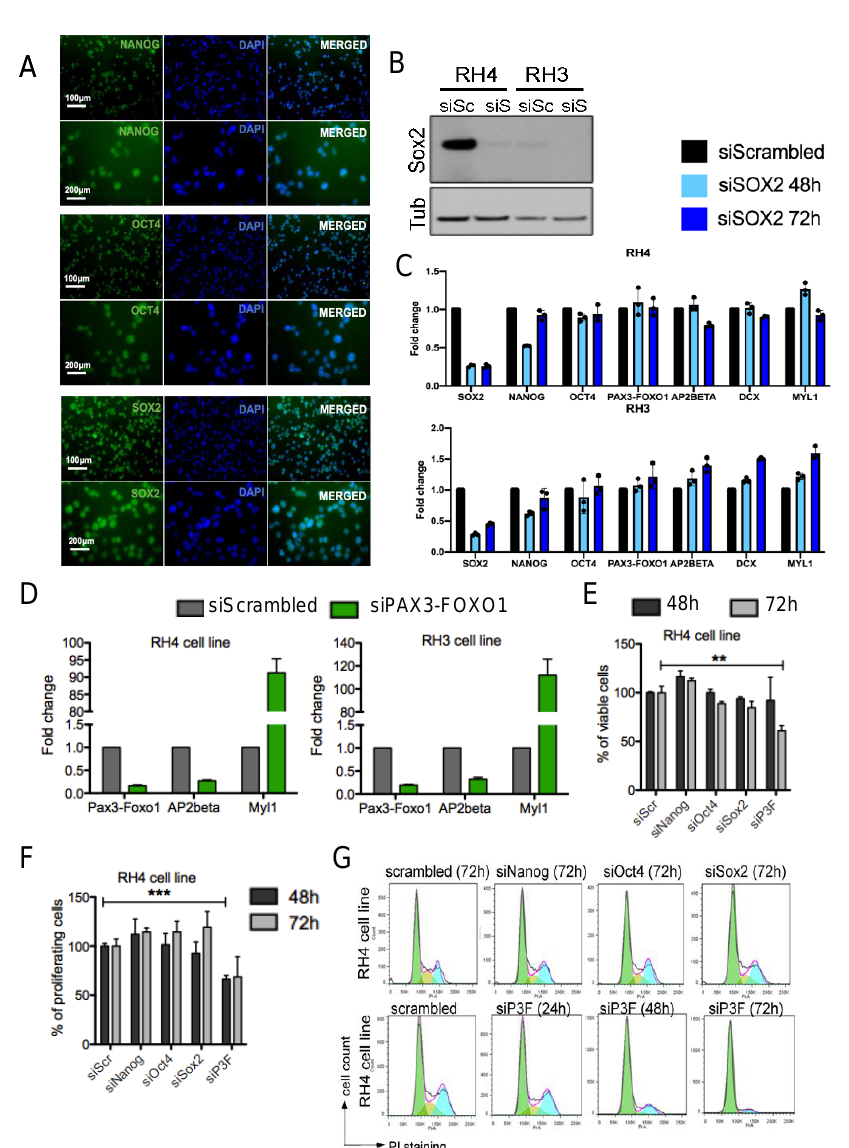
Figure 3. FPRMS cells express the core stem cell factors but only altered expression of PAX3-FOXO1 affects their cellular physiology. ( A ) Immunofluorescence for NANOG, OCT4, and SOX2 in RH3 cell line. ( B ) Western blot analysis of SOX2 expression after 72 h of siRNA-mediated silencing in RH4 and RH3 FPRMS cells. siSc = siScrambled; siS = siSOX2. ( C ) RNA expression analysis for the indicated genes after 48 h and 72 h of SOX2 silencing with a specific siRNA in RH4 and RH3 cells. Fold changes are calculated compared to cells treated with scrambled siRNA. Represented are means of triplicates ( n = 3). ( D ) RNA expression analysis for the indicated genes after 72 h silencing of PAX3-FOXO1 in RH4 and RH3 cells. Fold changes are calculated compared to cells treated with scrambled siRNA. Represented are means of triplicates ( n = 3). ( E ) Cell viability measurements (WST-1 assay) upon 48 h and 72 h of knockdown of PAX3-FOXO1 (siP3F), NANOG, OCT4, and SOX2 in RH4 cells. Percentage of viable cells was calculated compared to scrambled cells (siScr). Represented are means of triplicates ( n = 3). Statistical analysis: Unpaired t -test, ** p < 0.001. ( F ) Cell proliferation assay (BrdU incorporation) after 48 h and 72 h of PAX3-FOXO1, NANOG, OCT4, and SOX2 knockdown in RH4 cells. Percentages are calculated relative to the scrambled control cells. Represented are means of triplicates ( n = 3). Statistical analysis: Unpaired t -test, *** p < 0.0001. ( G ) Flow cytometric analysis of RH4 cell cycle distribution using propidium iodide (PI) upon silencing of PAX3-FOXO1 (siP3F), NANOG, OCT4, and SOX2 for the indicated time.